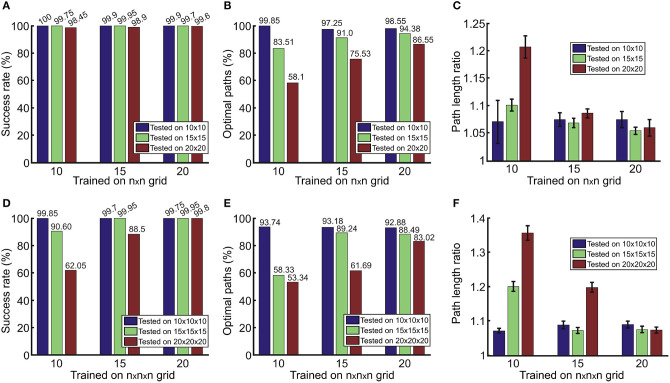
Results for the prediction of single paths in (A–C) 2D and (D–F) 3D environments obtained from 2,000 unseen environments for each case. Error bars in (C,F) denote confidence intervals of the mean (95%).